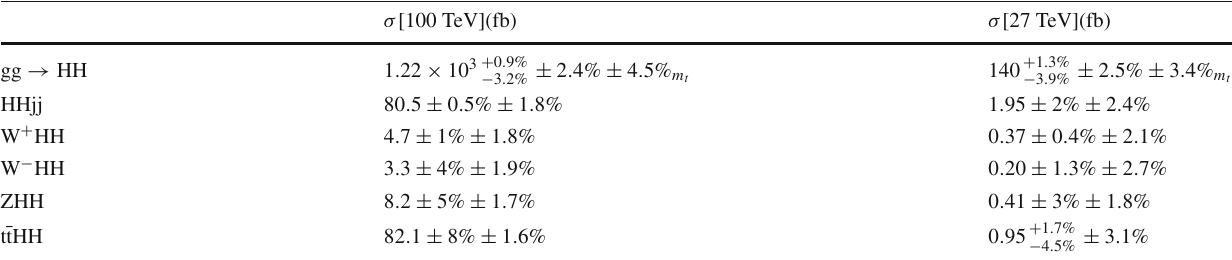
Table 10.1 Higgs-pair cross sections rates for various production processes [289]. The first uncertainty corresponds to the scale choice, the second combines α S and PDF systematics (PDF4LHC15NNLO), the third estimates finite- m top effects in the NNLO contribution to the gg